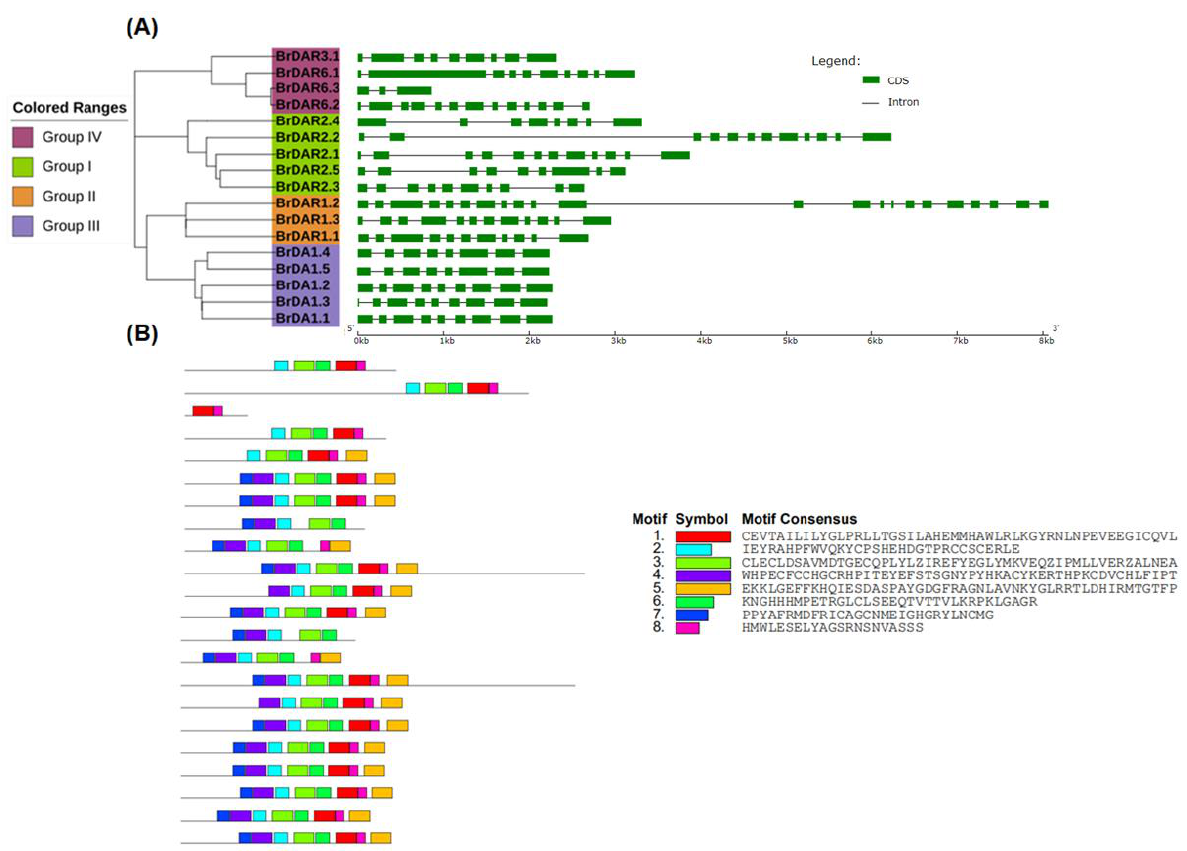
Figure 4. Structural and motif analysis of BrDA1 & DAR genes family. According to the phylogenetic analysis, the BrDA1 & DAR genes were classified into four groups. ( A ) Gene structure analysis. ( B ) The conserved motifs of BrDA1&DARs.